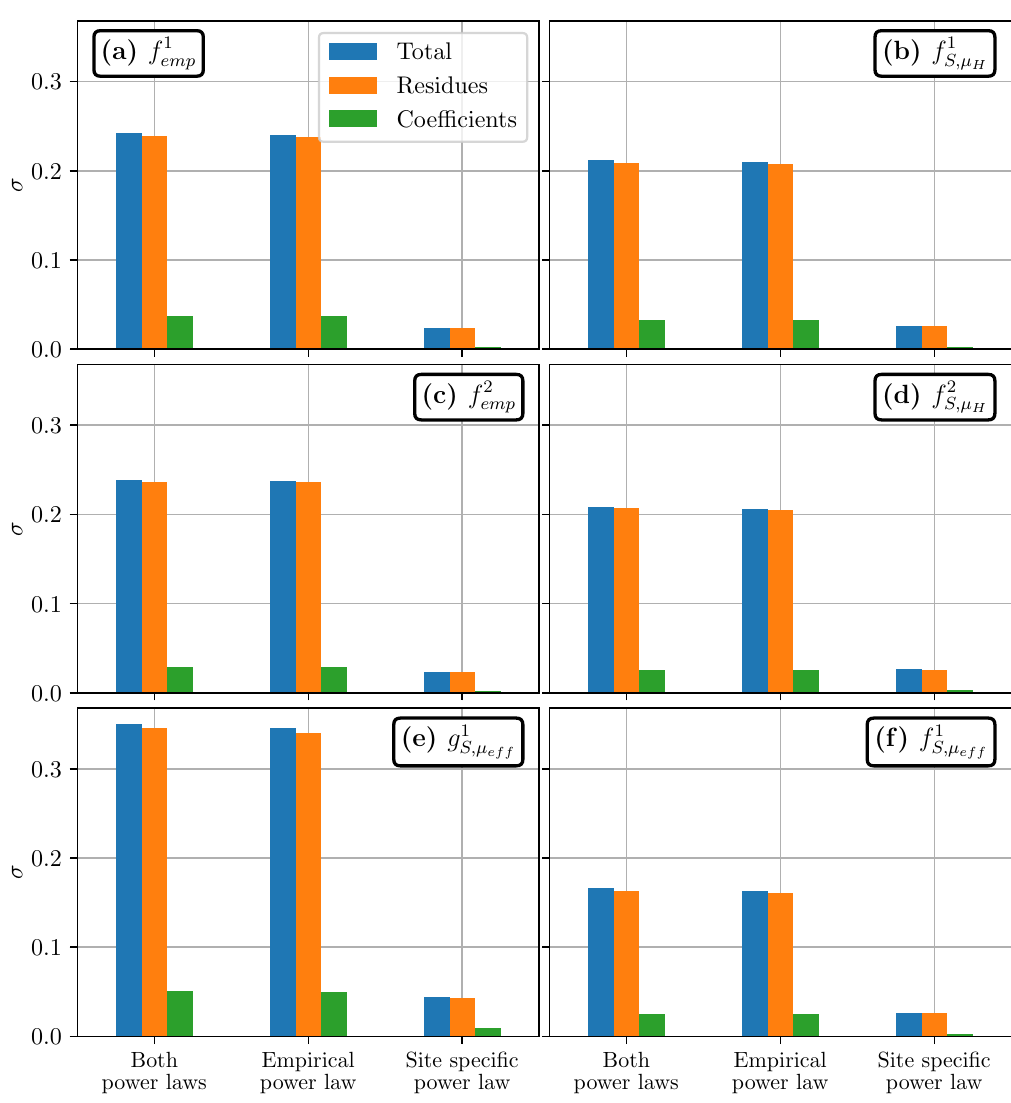
Figure A3. Uncertainty in travel distance estimation for the Frank Slide cliff case study. ( a – f ), and symbology are the same as for Figure